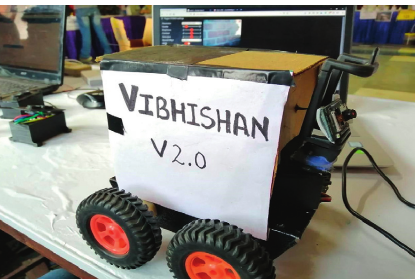
Figure 16: The robot used for the safety of food and